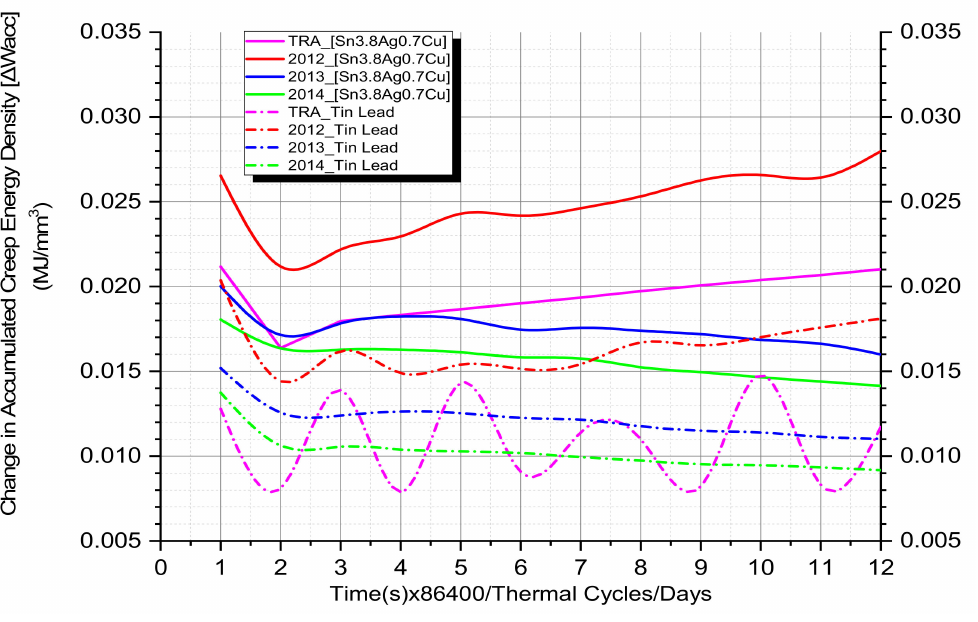
Figure 4. Change in ACED over daily thermal